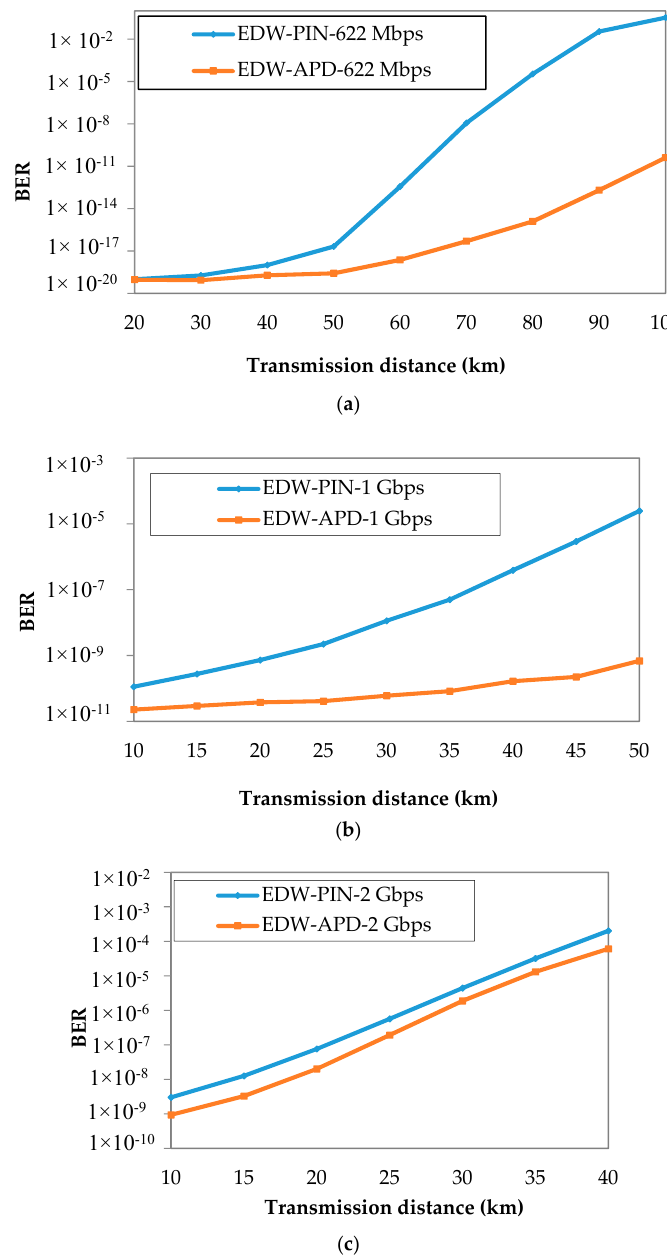
Figure 3. SAC-OCDMA system performance in terms of bit error rate (BER) using EDW codes and two different detectors in the absence of erbium-doped fiber amplifier (EDFA) and dispersion compensating fiber (DCF) at bit rates ( a ) 622 Mbps, ( b ) 1 Gbps, and ( c ) 2 Gbps (PIN detector is indicated by the blue line and avalanche photodiode (APD)by the red line).